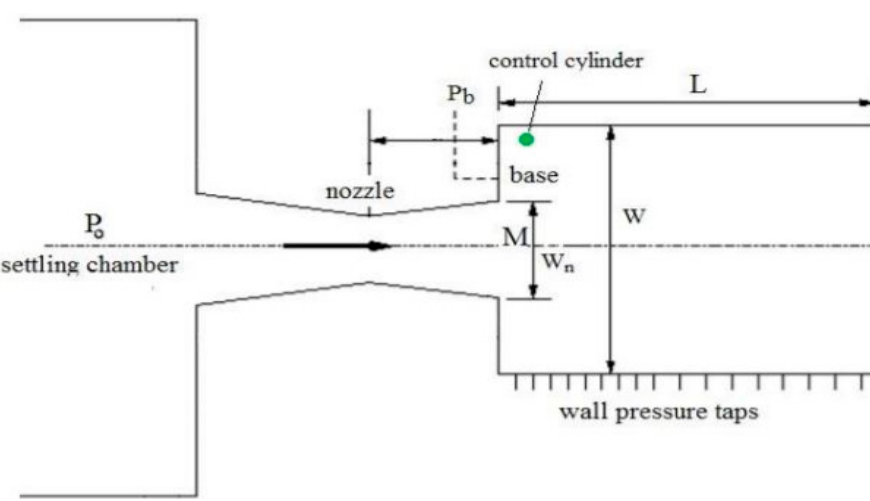
Figure 11. Experimental setup [20].